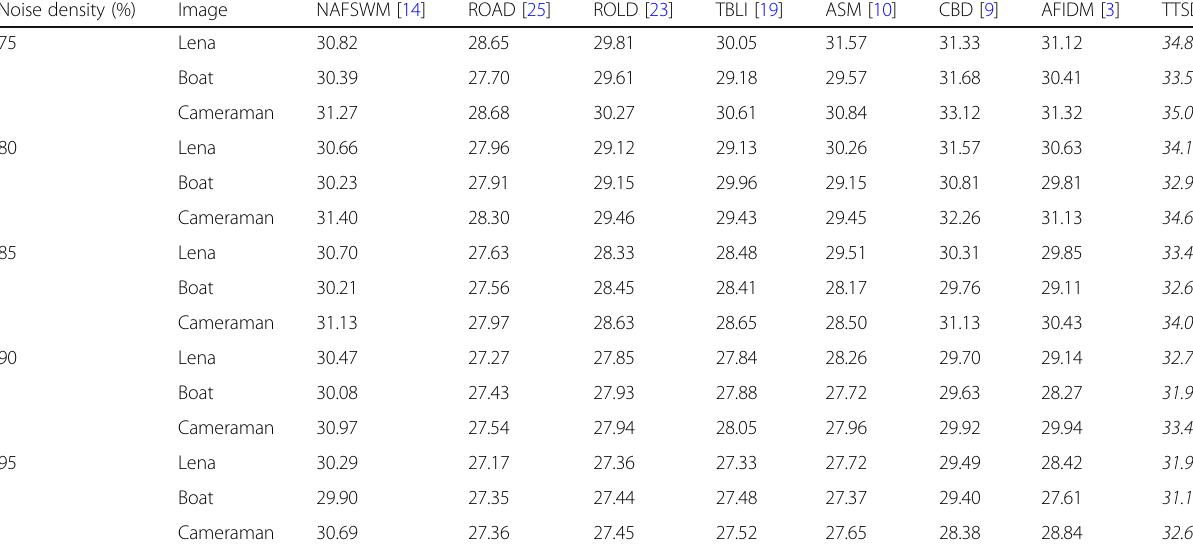
Table 2 Restoration results in PSNR (dB) for Lena, Boat, and Cameraman images corrupted by RVIN Noise density (%)